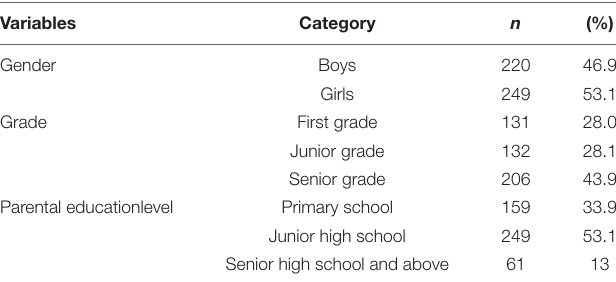
TABLE 1 | The description of the original sample characteristics based on gender, grade, parental education